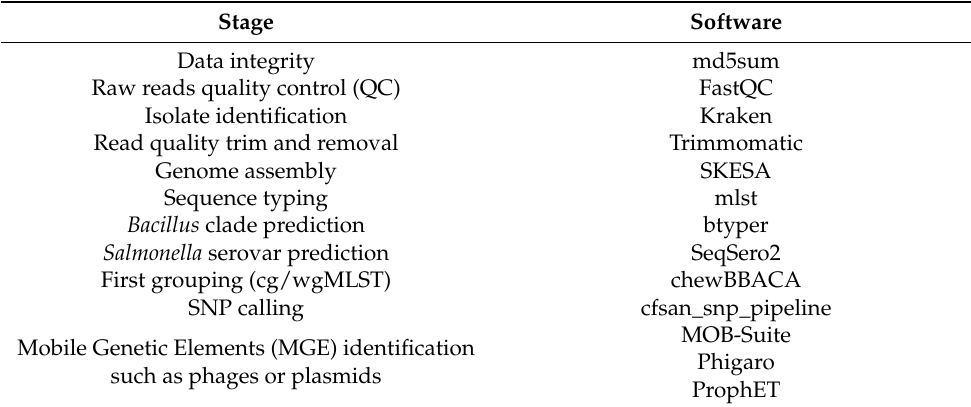
Table 2. List of currently implemented software in our workflow.